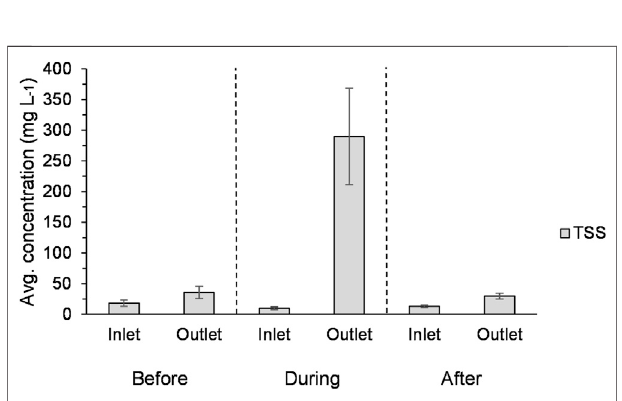
FIGURE 4 | Base fl ow average (SE) TSS concentration at the CW inlet and outlet, before, during and after maintenance.